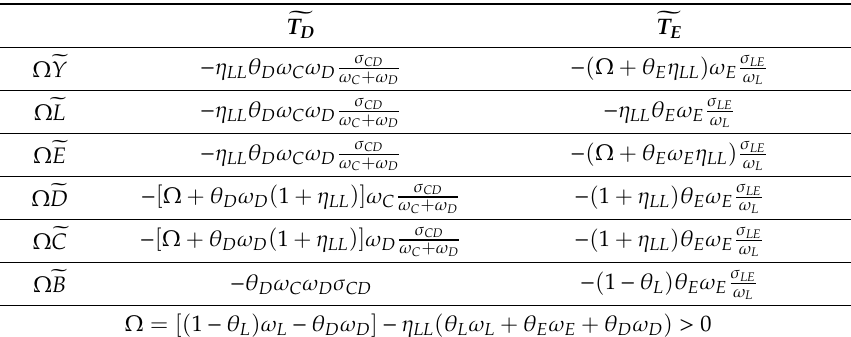
Table 3. Simplified solutions of the